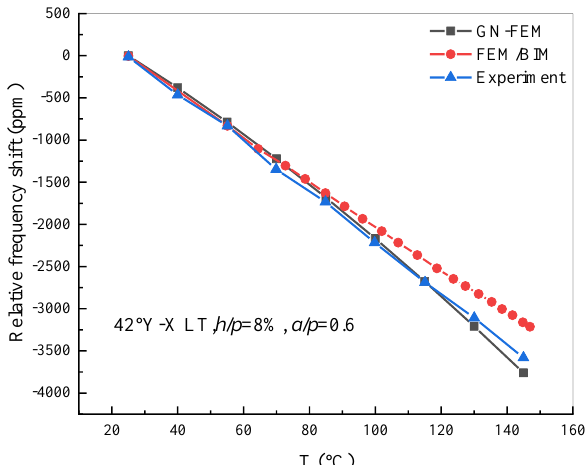
Figure 10. Comparison of the theoretical results and experimental relative resonance frequency shift of 42° Y-X LT.